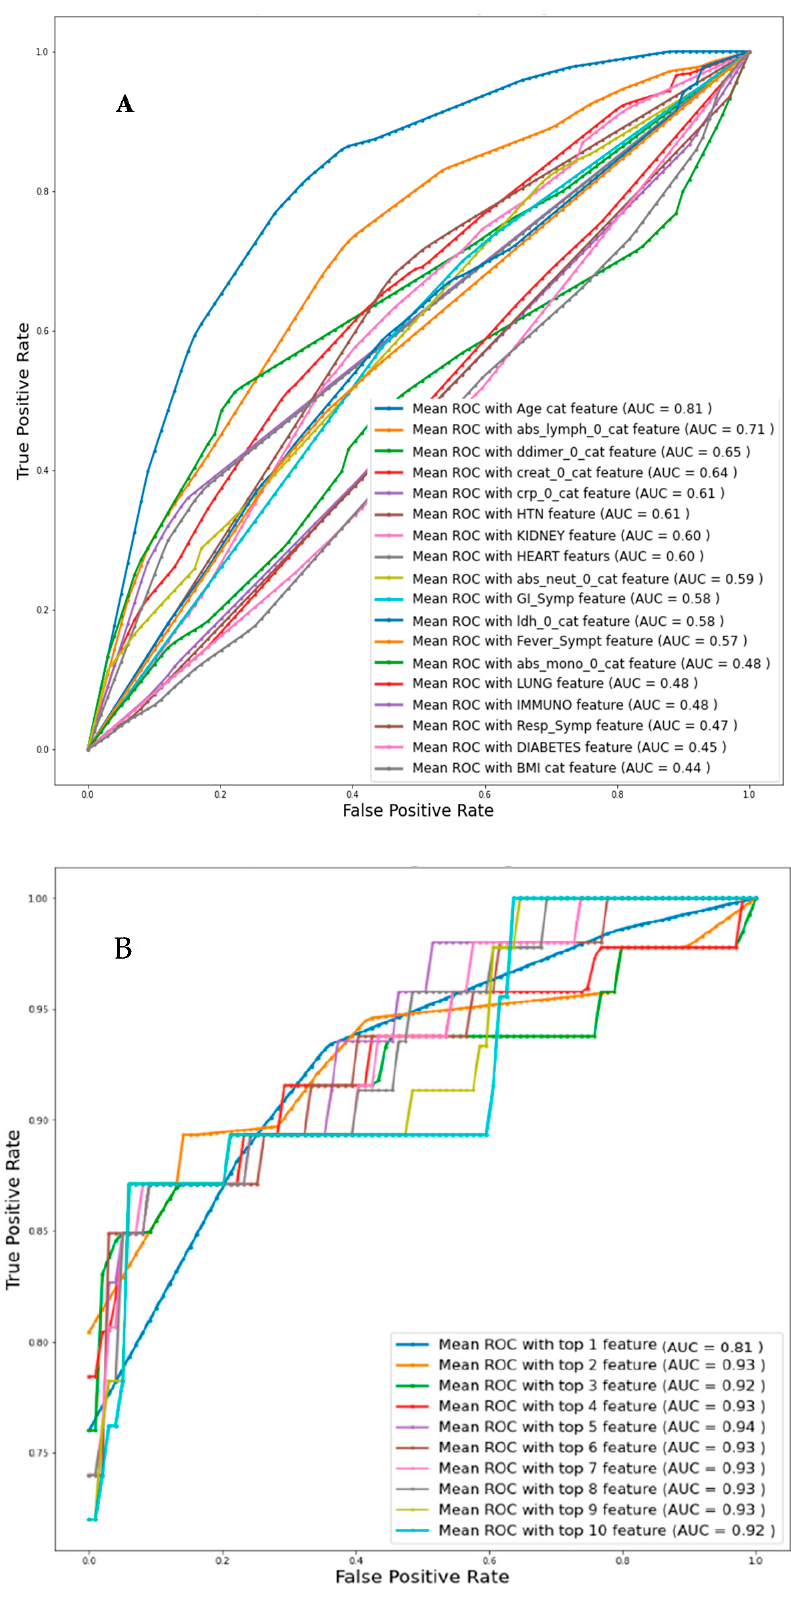
Figure 3. Comparison of the receive operating characteristic (ROC) plots for ( A ) individual feature (Imputation-Mice, Classifier-Logistic regression), ( B ) top-ranked 1 up to 10 features (Imputation-Mice, Classifier-Logistic